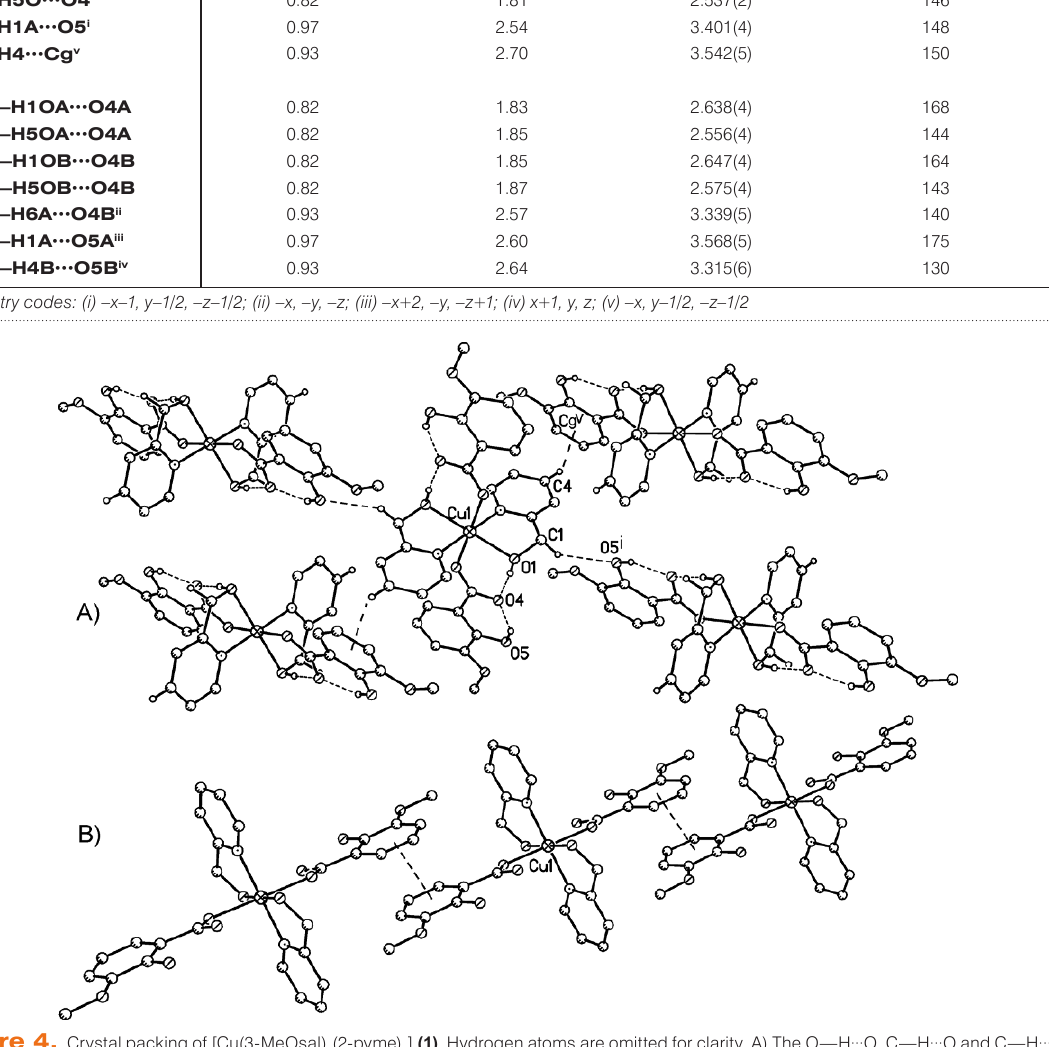
–y+1, –z] in π – π stacking interactions [64]. The distance